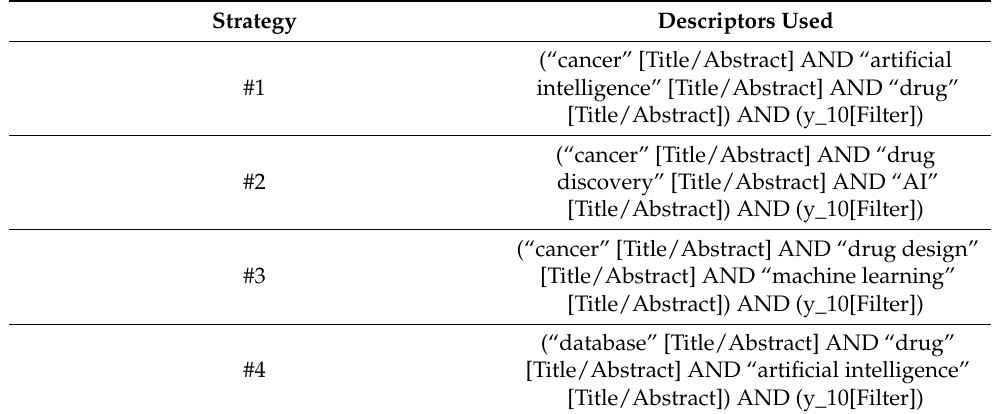
Table 1. Search strategies used in the US National Library of Medicine (PubMed), according to selected